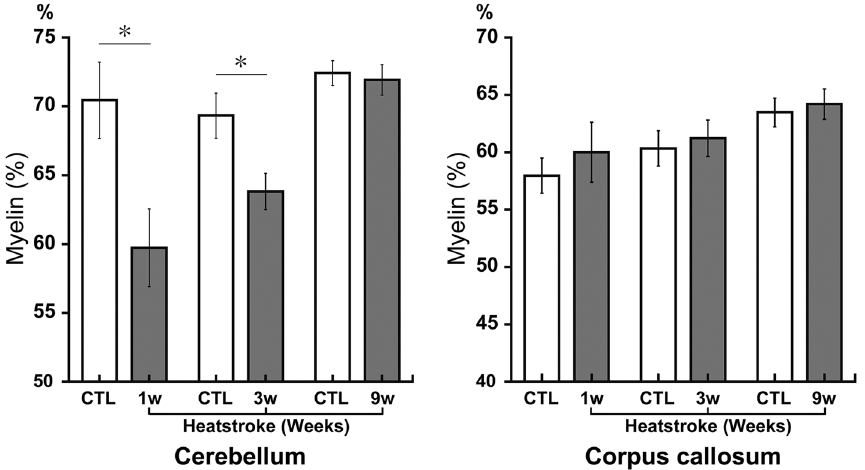
Figure 2. Cerebellum myelin sheaths in heatstroke animals temporarily decreased with Klüver–Barrera staining after heatstroke. The amount of myelination was semi-quantified in the white matter (WM) of the cerebellum and corpus callosum (CC) after heatstroke. Semi-quantification of the myelin staining revealed that the myelinated percentages were significantly decreased at 1 and 3 weeks after heatstroke, and it recovered 9 weeks later. No differences were observed between the HS and CTL groups in the CC. Data are expressed as mean ± SD (* P < 0.05, Student’s t test). SD standard deviation, CTL control.